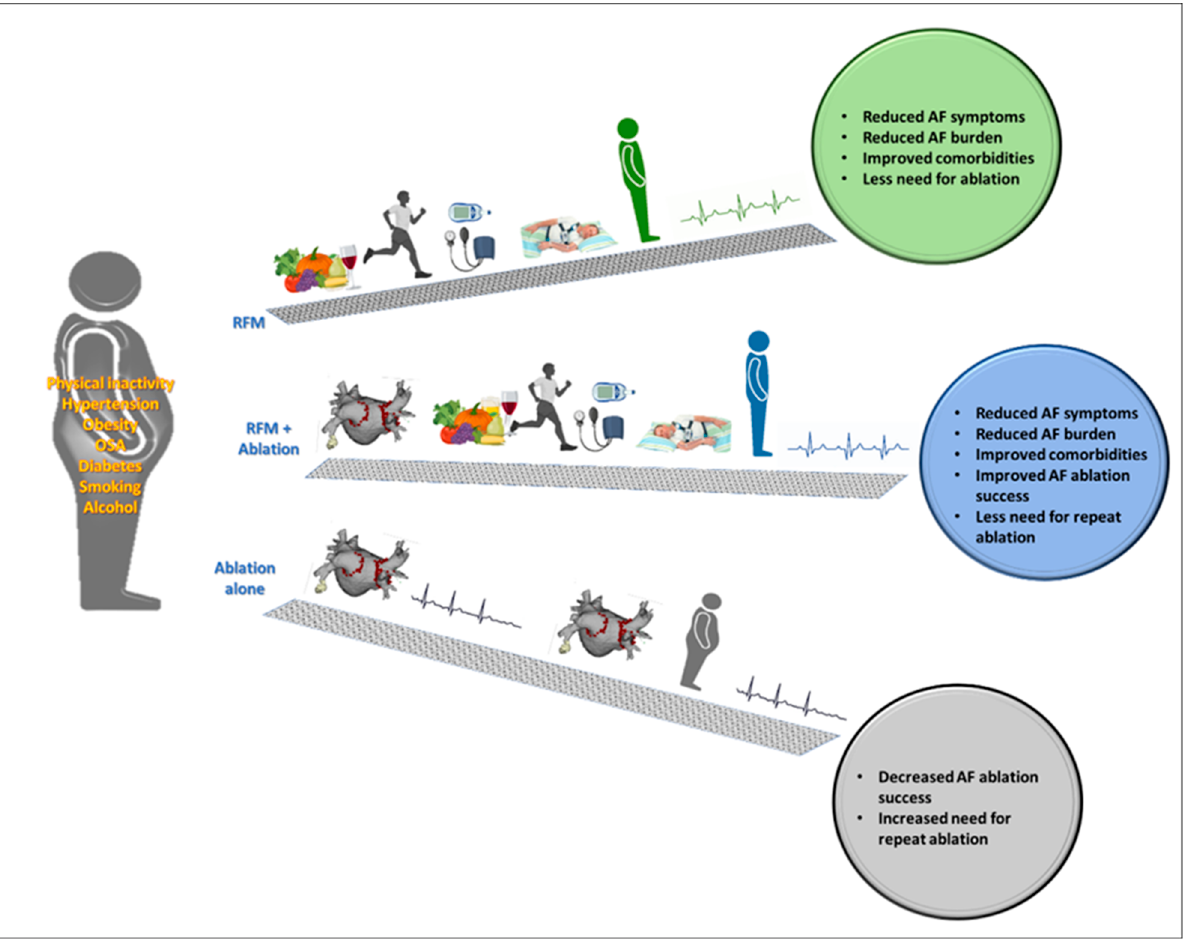
Figure 1. Effects of risk factor management (RFM) for AF including the benefit of undertaking risk factor management as a primary method of care for atrial fibrillation (AF) patients. Benefits are also seen in those who require ablation, with lower benefit for AF ablation alone in those who present with risk